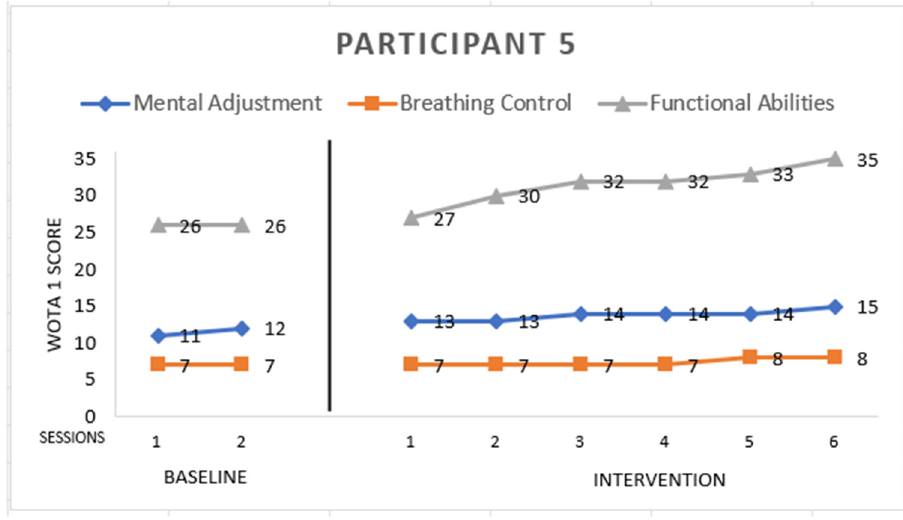
Figure 5. Highest possible scores: Mental Adjustment = 16, Breathing Control = 8, Functional Abilities =